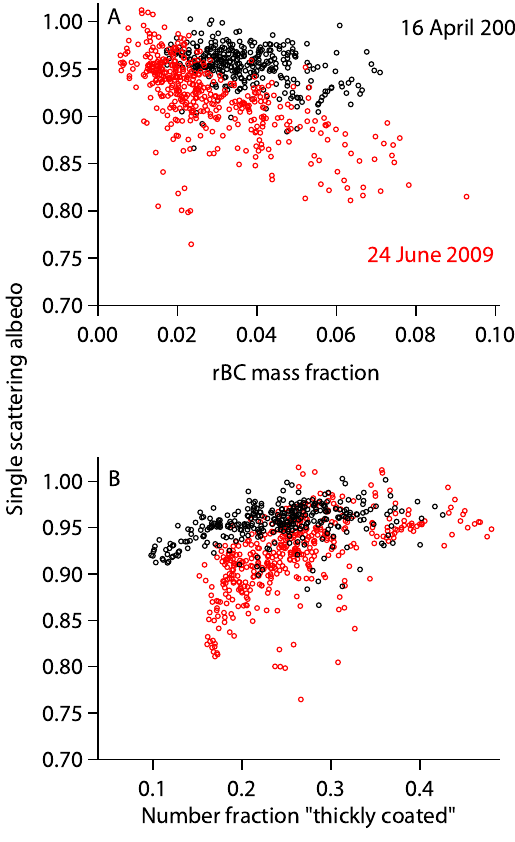
Fig. 8. Aerosol single scattering albedo calculated as the ratio of light scattering coefficients to total extinction coefficients plotted as a function of the rBC mass fraction of total sub-micron mass and the number fraction of thickly coated rBC particles detected by the